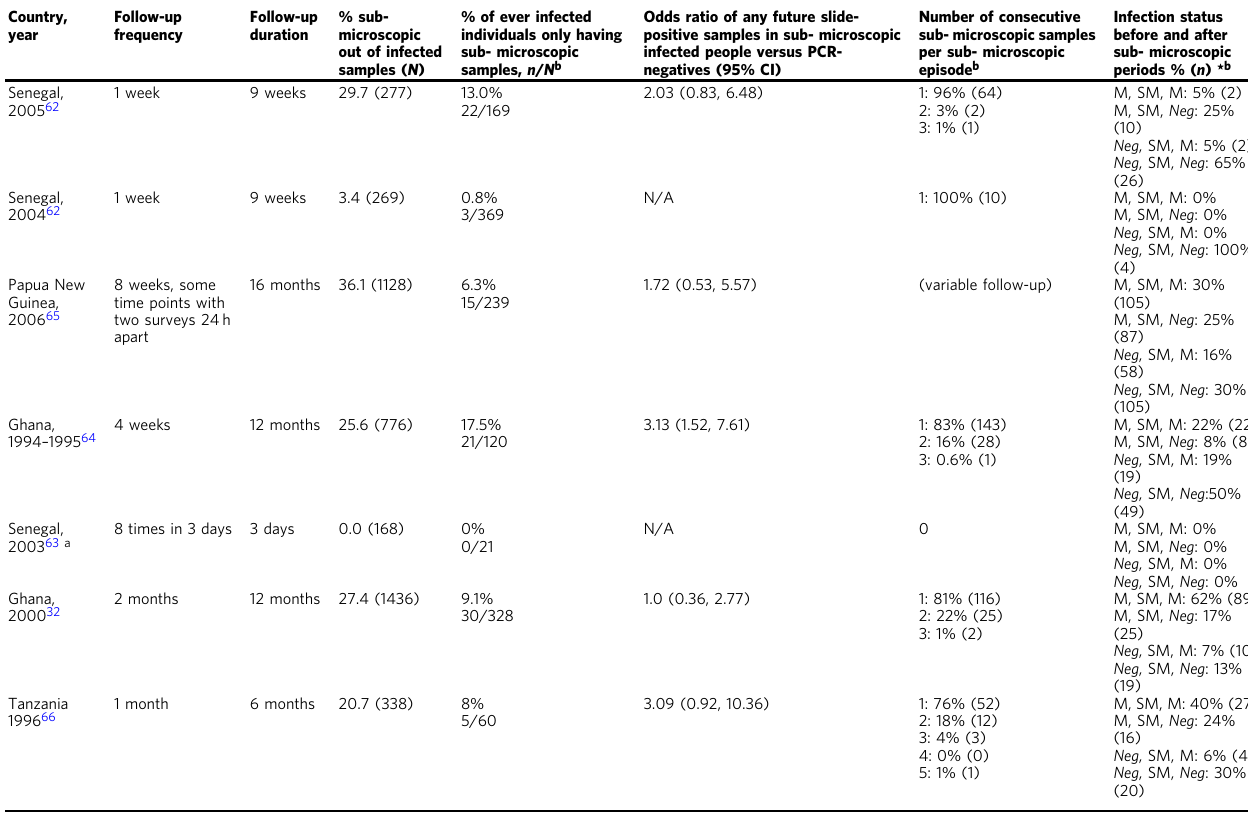
Table 1 Dynamics of infections detected by microscopy/RDT and PCR during longitudinal studies Country, Follow-up Follow-up % sub- year frequency duration microscopic out of infected samples ( N